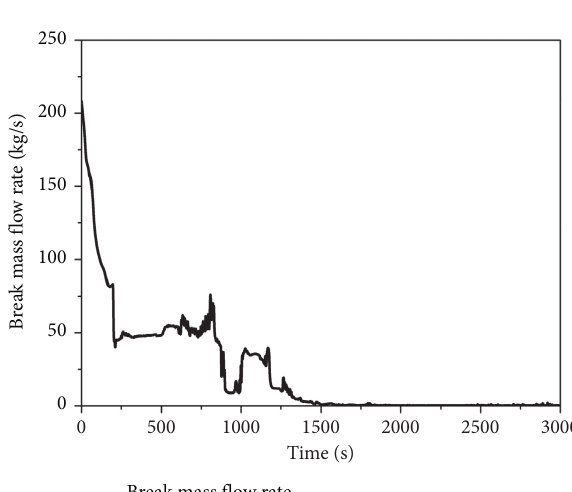
Figure 16: 2-inch CL break mass flow